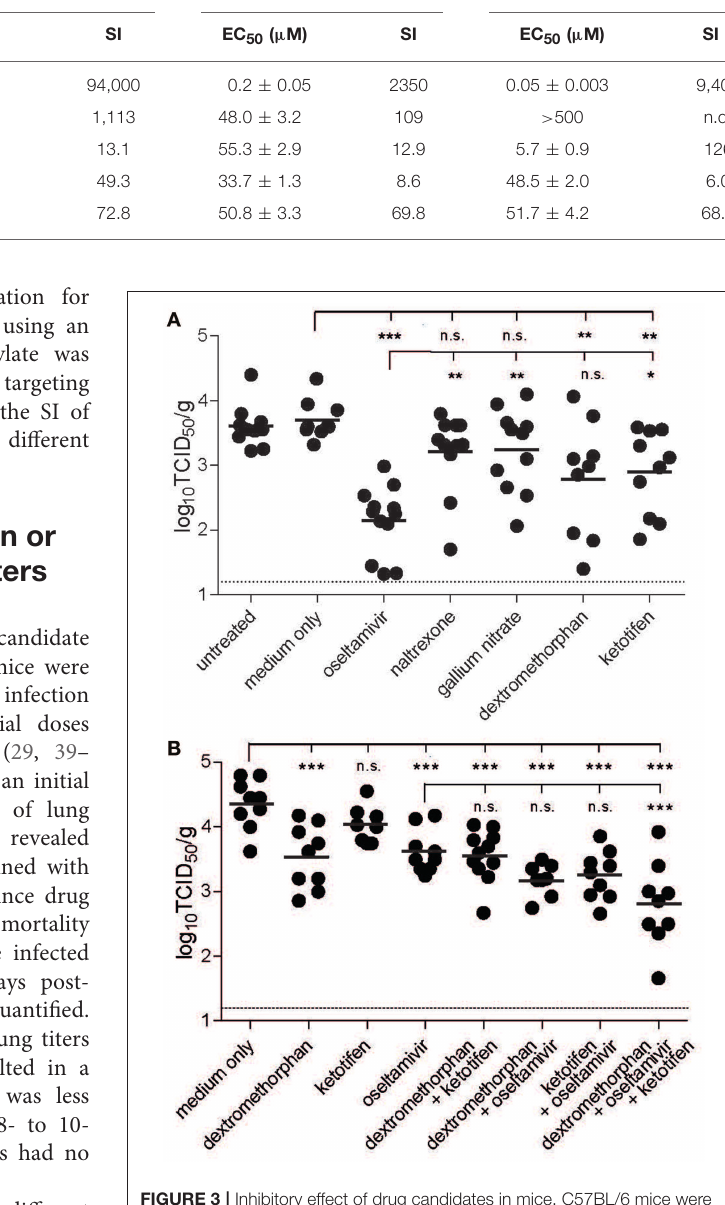
suggesting a modest benefit of combination treatment in this